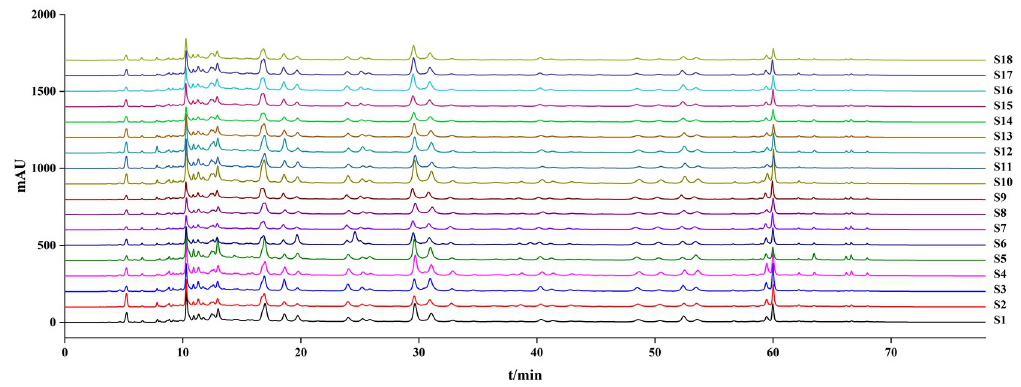
Fig 4. The chromatograms of S1 ~ S18.